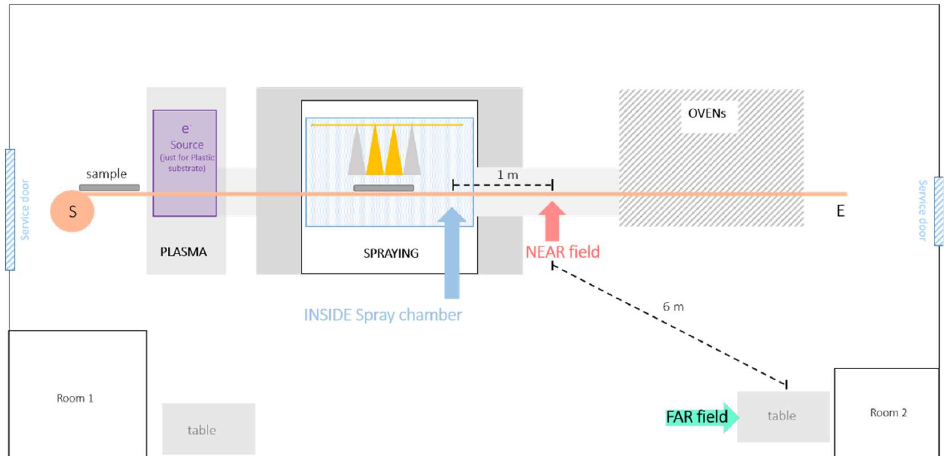
Figure 1. Schematization of the Witek s.r.l plant and measurement stations (inside, near field and far field).